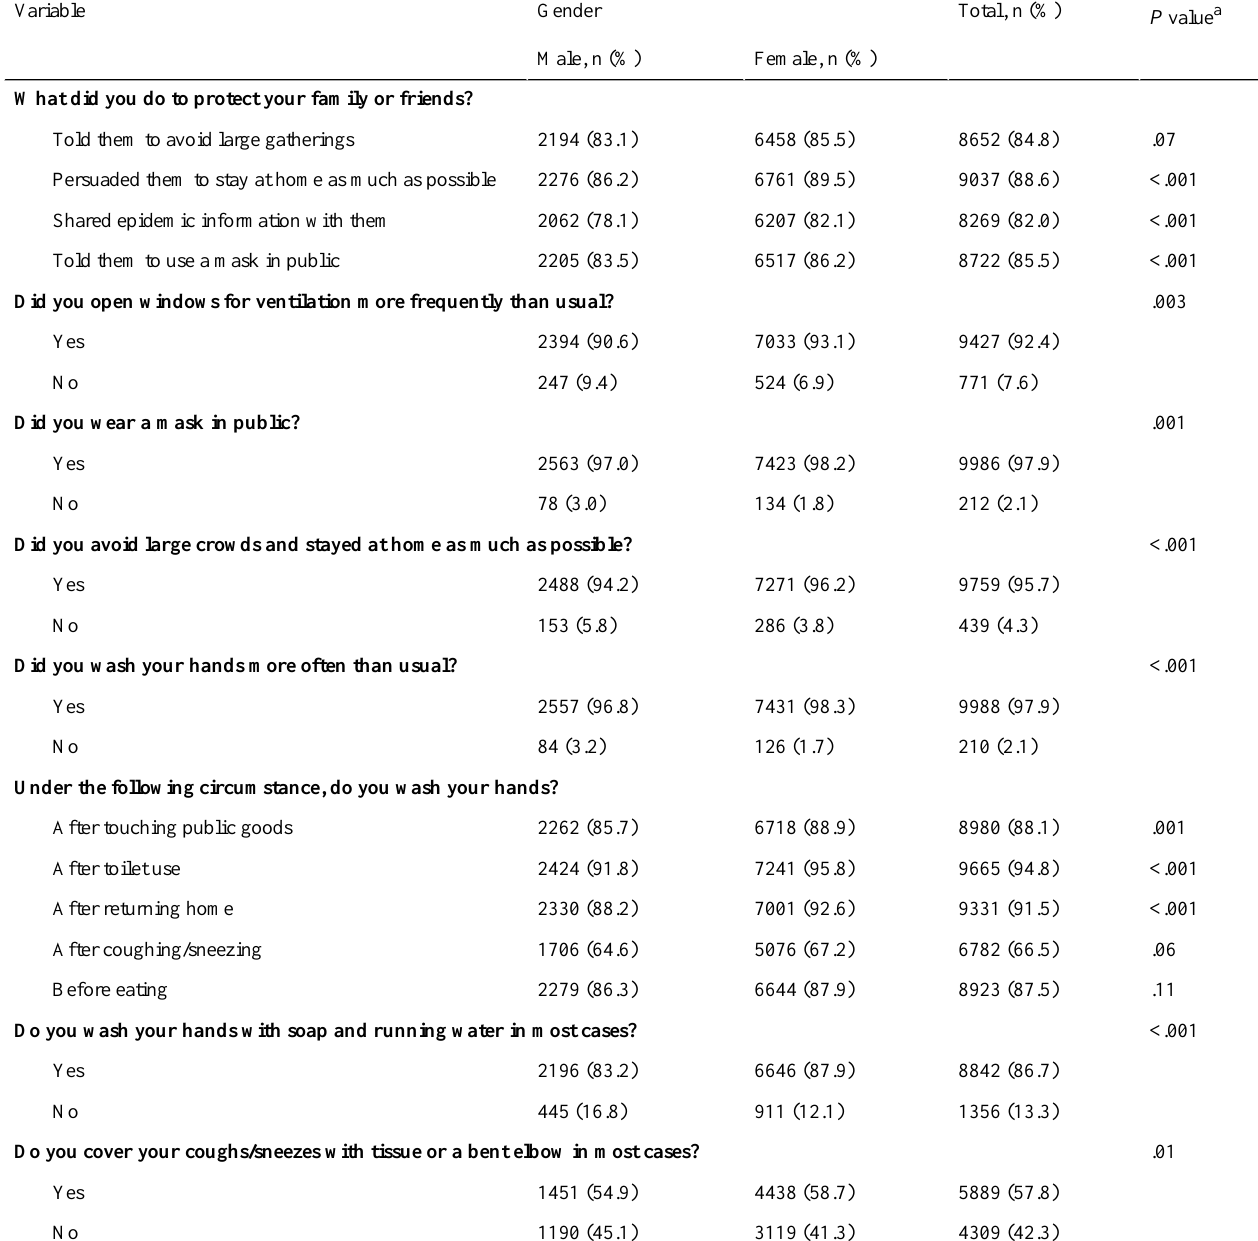
P value a Total, n (%)GenderVariable